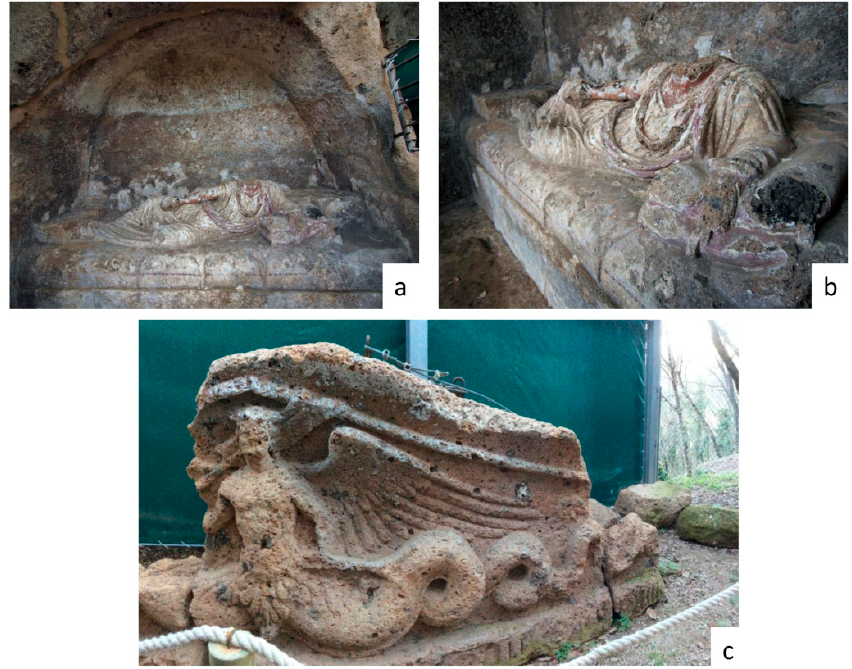
Figure 3. Some details of the Tomba dei Demoni Alati: ( a ) the niche with the recumbent figure; ( b ) the recumbent figure; ( c ) the pediment with the sea demon Scylla.